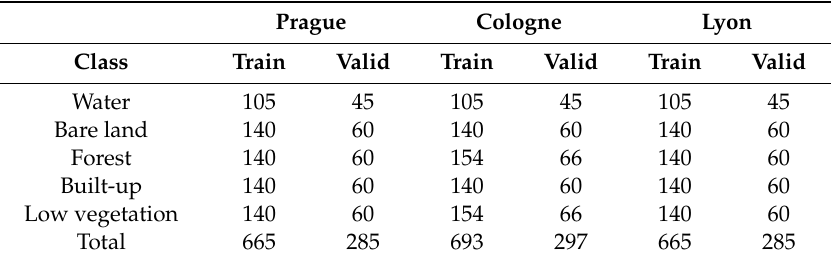
Table 2. The polygon samples used for training (Train) and validation